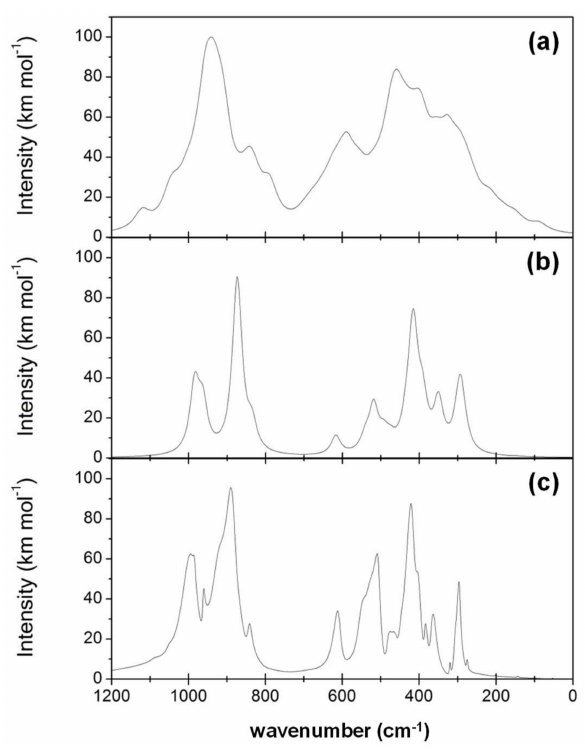
Figure 5. B3LYP-simulated IR spectra of the amorphous ( a ) and crystalline forsterite ( b ). The experimental spectrum of the crystalline forsterite is also included ( c ).